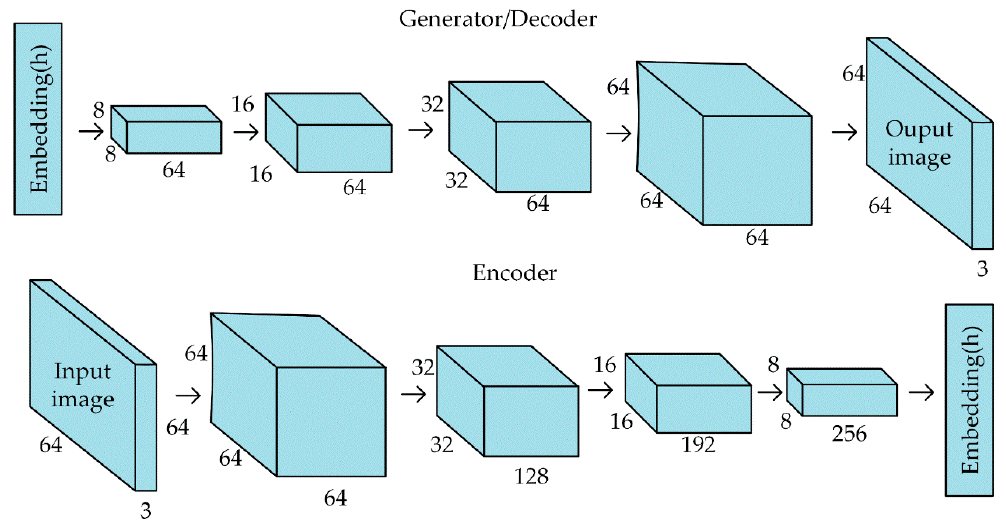
Figure 11. BEGAN Figure 11. BEGAN network. Figure 11. BEGAN network.